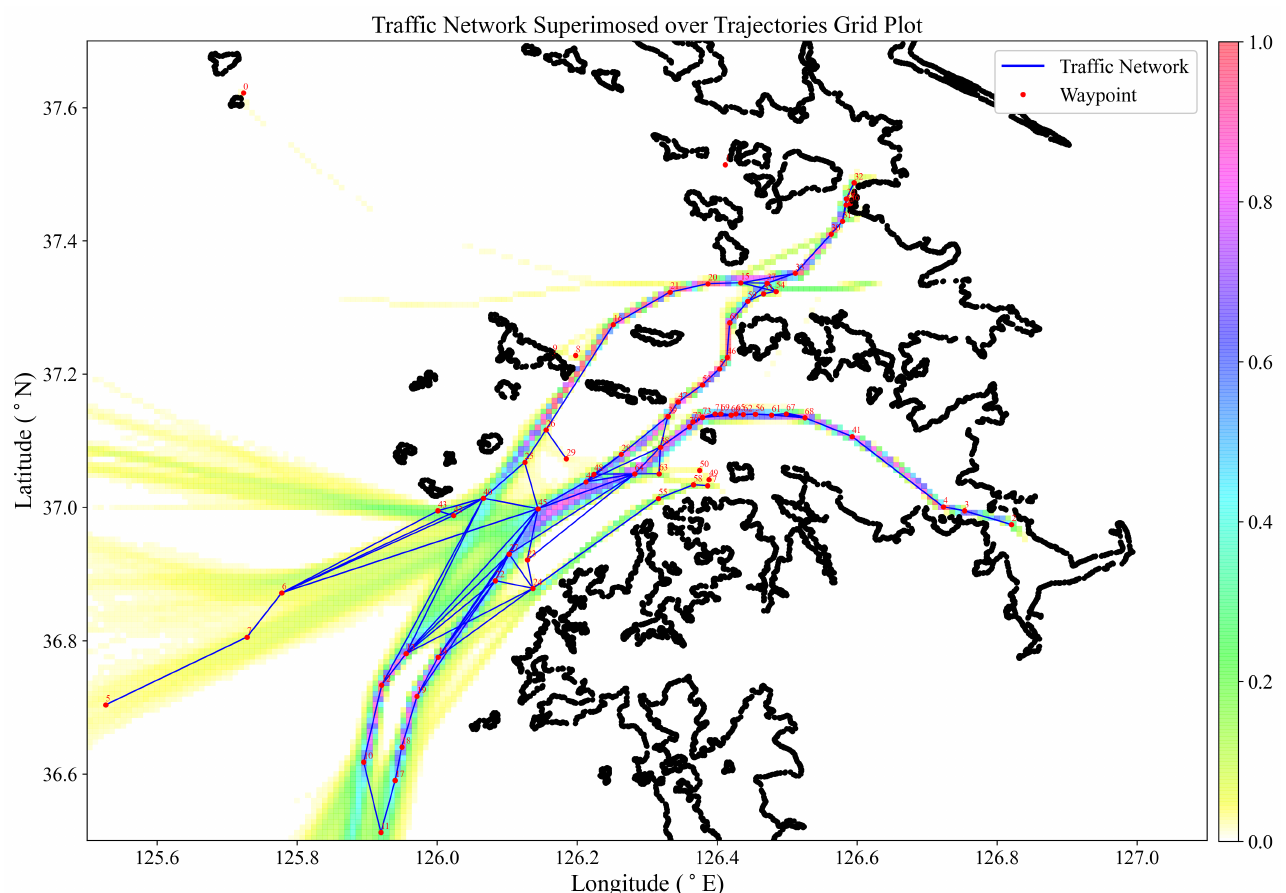
Figure 10. Maritime traffic network and waypoints superimposed on AIS trajectories grid plot for verification using SSPD